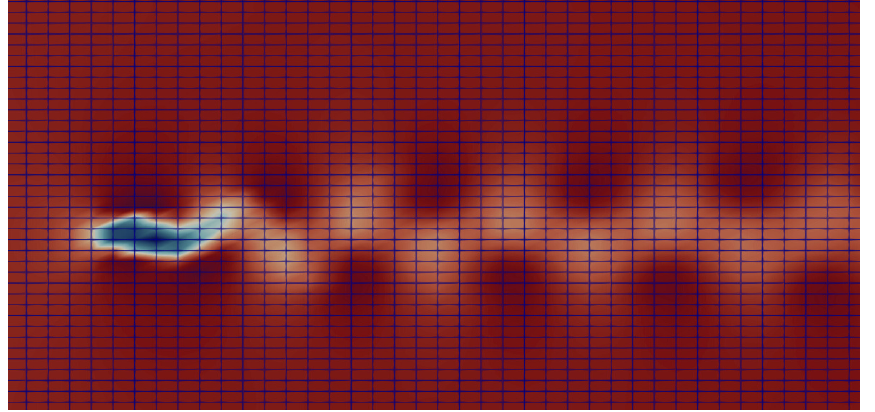
Figure 3. The finite element projection of the instantaneous velocity, Figure 2, on mesh n°1 in Table 1.